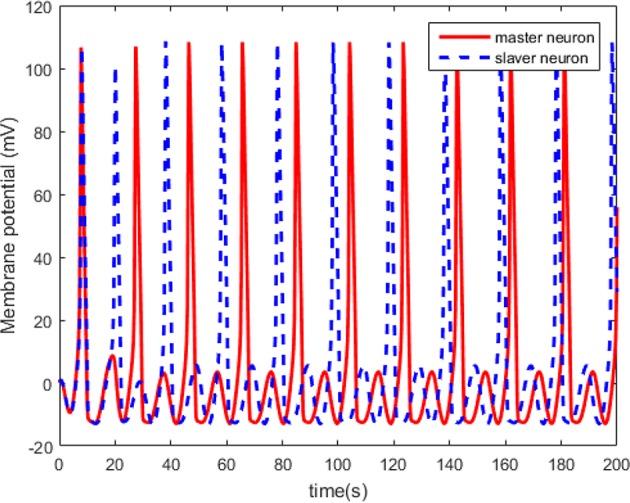
The original membrane potential curves of the master and the slaver HH neurons.